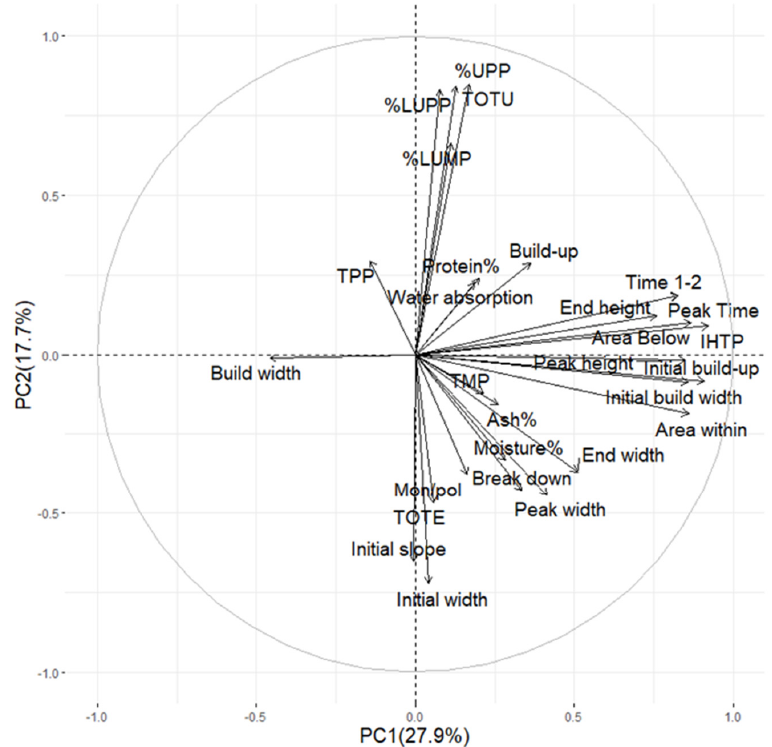
Figure 2. Principal component analysis (PCA) plot of mixograph parameters in dough and protein composition parameters in flour of 56 spring wheat genotypes grown in cool (2017) and heat–drought (2018) years evaluated by SE-HPLC; protein (%), ash (%), and flour moisture (%) were determined in flour by NIT (taken from Lama et al. 2022).